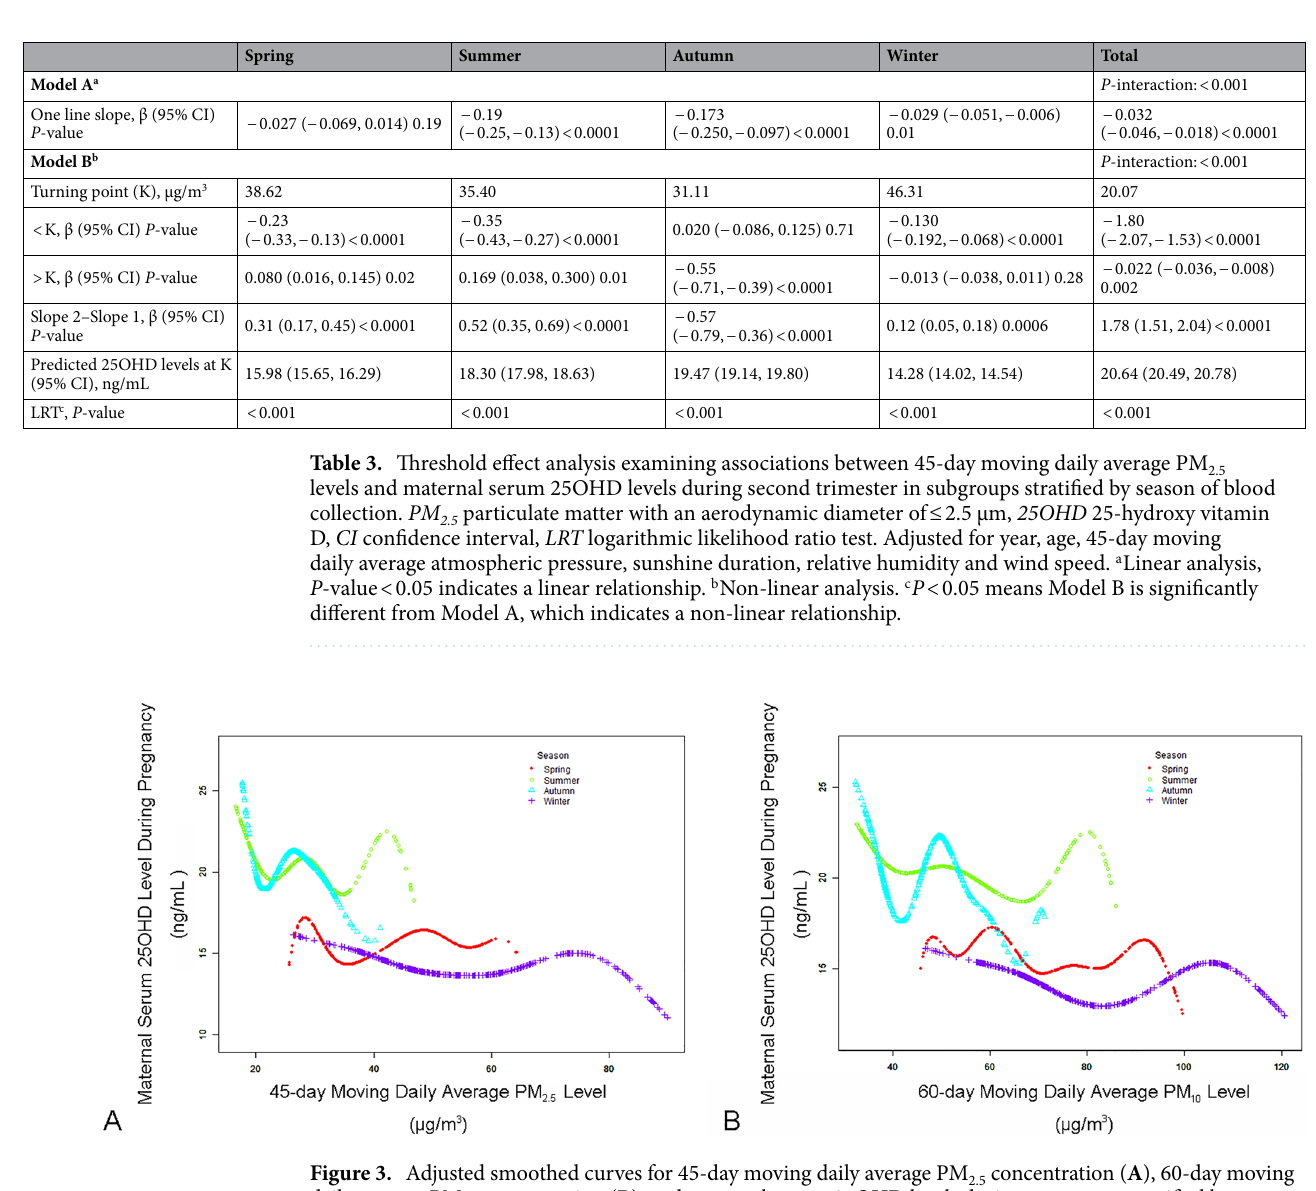
Figure 3. Adjusted smoothed curves for 45-day moving daily average PM 2.5 concentration ( A ), 60-day moving daily average PM 10 concentration ( B ), and maternal serum 25OHD levels during pregnancy stratified by seasons. Thresholds were nonlinear associations between PM and 25OHD, as evidenced in generalized additive models. Adjustment factors included year, age, corresponding-day moving daily average atmospheric pressure, sunshine duration, relative humidity, and wind speed. 25OHD 25-hydroxy vitamin D, PM 2.5 particulate matter with an aerodynamic diameter of ≤ 2.5 μm, PM 10 particulate matter with an aerodynamic diameter of ≤ 10 35.2% of pregnant women during the second trimester of pregnancy, respectively. We found that the maximum cumulative effects of PM 2.5 occurred at lag 45 days and the maximum cumulative effects of PM 10 occurred at lag 60 days. However, the effect values were drastically reduced after adjusting for temporal and/or meteorological factors. The results indicated that PM has a limited influence on maternal serum 25OHD levels. The list of studies that have linked VDD to complications of pregnancy continues to grow: vitamin D sta- tus has been associated with gestational diabetes 36–39 , aeroallergen sensitization 40 , and markers of regulatory immunity 41 . A meta-analysis of eight studies found a significant association between VDD and the risk of pre-eclampsia, which was more evident in studies that defined VDD as 25OHD < 50 nmol/L and those from the USA 42 . In addition, a meta-analysis of 24 observational studies confirmed the association between VDD (< 50 nmol/L) and an increased risk of preterm birth (OR 1.58; 95% CI 1.08 to 2.31) 43 . With respect to birth- weight, a meta-analysis of three observational studies found a weak positive association between maternal vita- min D status and birthweight after adjusting for potential confounders 44 . In addition, recent reviews suggested that appropriate levels of vitamin D during pregnancy are associated with less morbidity during pregnancy 45,46 . Zhao et al. reported an association between prenatal exposure to higher PM 2.5 and PM 10 levels and a decrease in circulating 25OHD concentrations in women in the third trimester and the entire pregnancy 24 . They reported a 10 μg/m 3 increase in PM 2.5 and PM 10 exposure during the entire pregnancy was associated with a 4.62% (95%